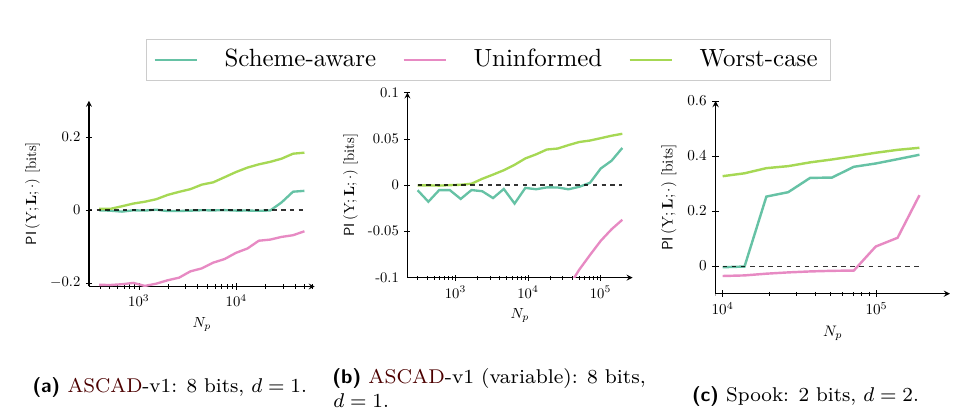
Figure 8: Learning curves (best validation